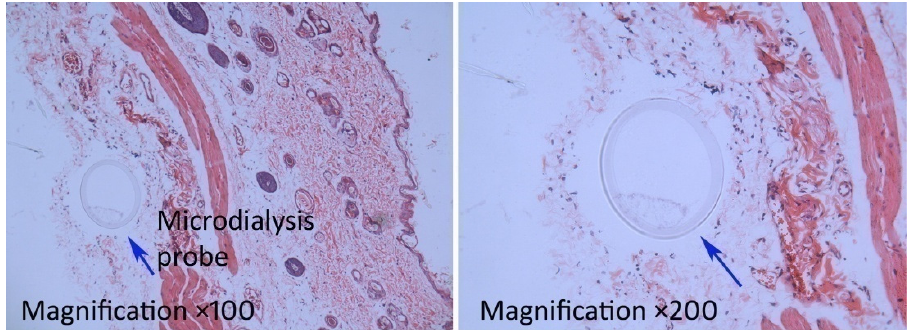
Figure 4. Aconitine concentration in deep skin tissue by using microdialysis sampling after application of aconitine-loaded microemulsion and aqueous solution to the abdominal skin of Sprague–Dawley rats in vivo ( n = 3).